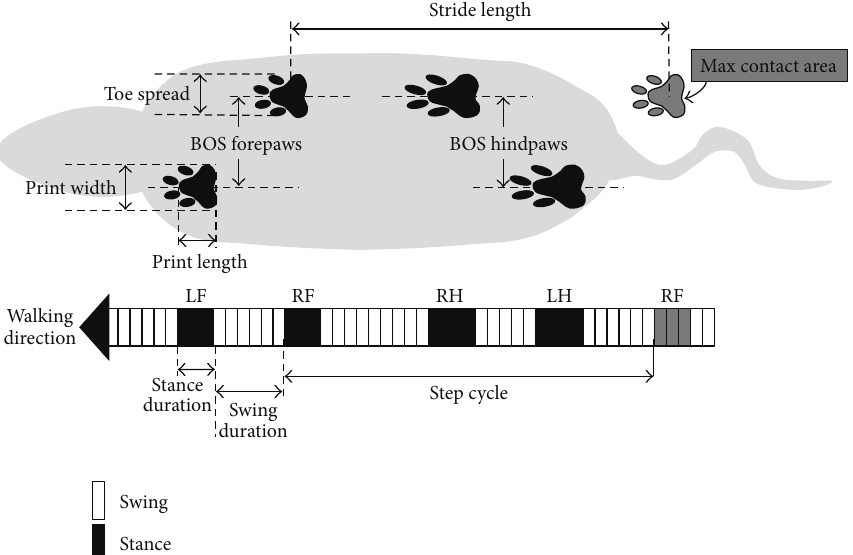
Figure 2: Graphical representation of selected gait parameters. The animal is walking towards the left. Black and white boxes represent time fractions where the paw is in contact with the surface or lifted at walking. RF: right forelimb; LF: left forelimb; RH: right hindlimb; LH: left